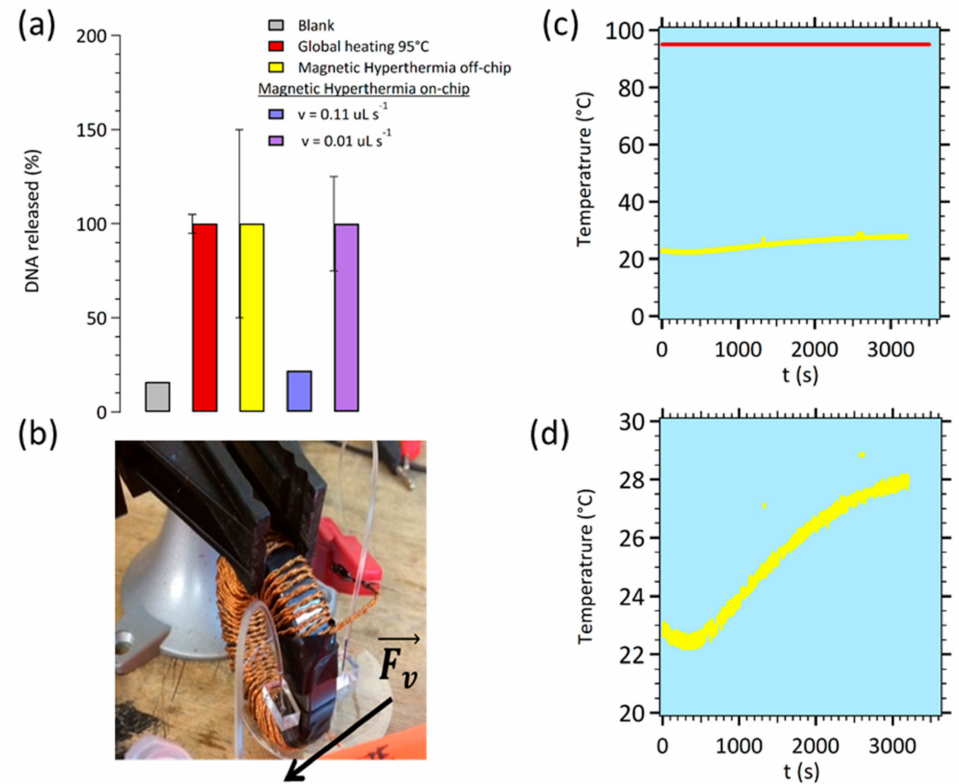
Figure 3. ( a ) Comparison of the results obtained for released DNA targets measured by fluoro- metric detection after: global heating (batch), off-chip magnetic hyperthermia (batch) and on-chip magnetic hyperthermia (according to the two flow rates used in geometry A). ( b ) Photography of the on-chip magnetic hyperthermia connected for samples introduction and collection (off-chip fluorometric dosing). ( c ) Monitoring of the temperature during the global heating 95 ◦ C (red curve) compared to magnetic hyperthermia experiment (yellow curve). ( d ) Enlarged area of monitoring of the temperature from 23 to 28 ◦ C during the magnetic hyperthermia